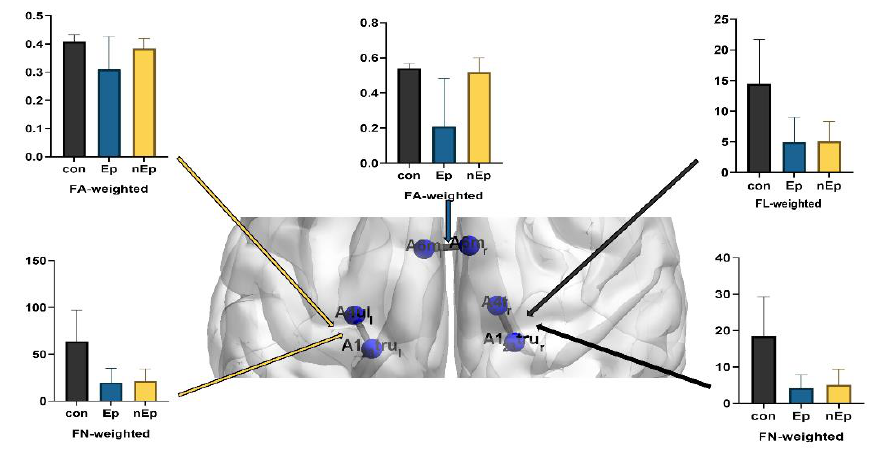
Figure 3. Connection